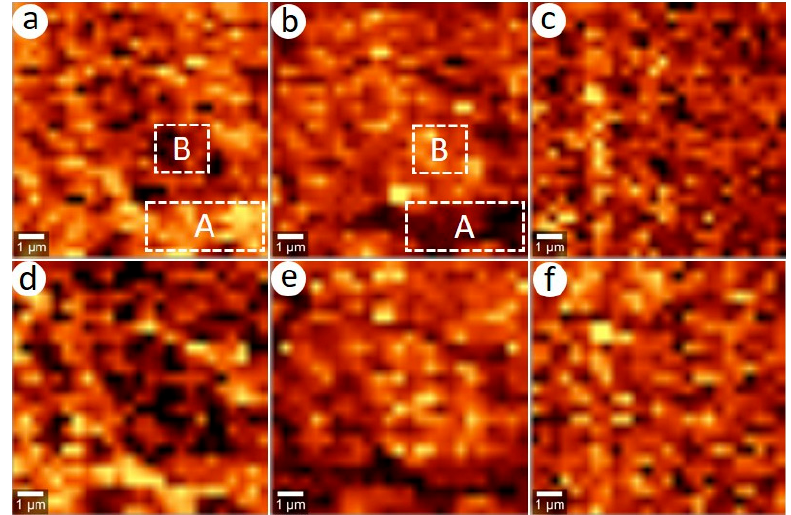
Figure 3. Raman maps for chalcopyrite samples leached in the presence of ferric at 14 ( a – c ) and 42 days ( d – f ). (a) and (d) 272 cm − 1 ; (b) and (e) 294 cm − 1 ; (c) and (f) 355 cm − 1 . ( d – f ). ( a ) and ( d ) 272 cm − 1 ; ( b ) and ( e ) 294 cm − 1 ; ( c ) and ( f ) 355 cm − 1